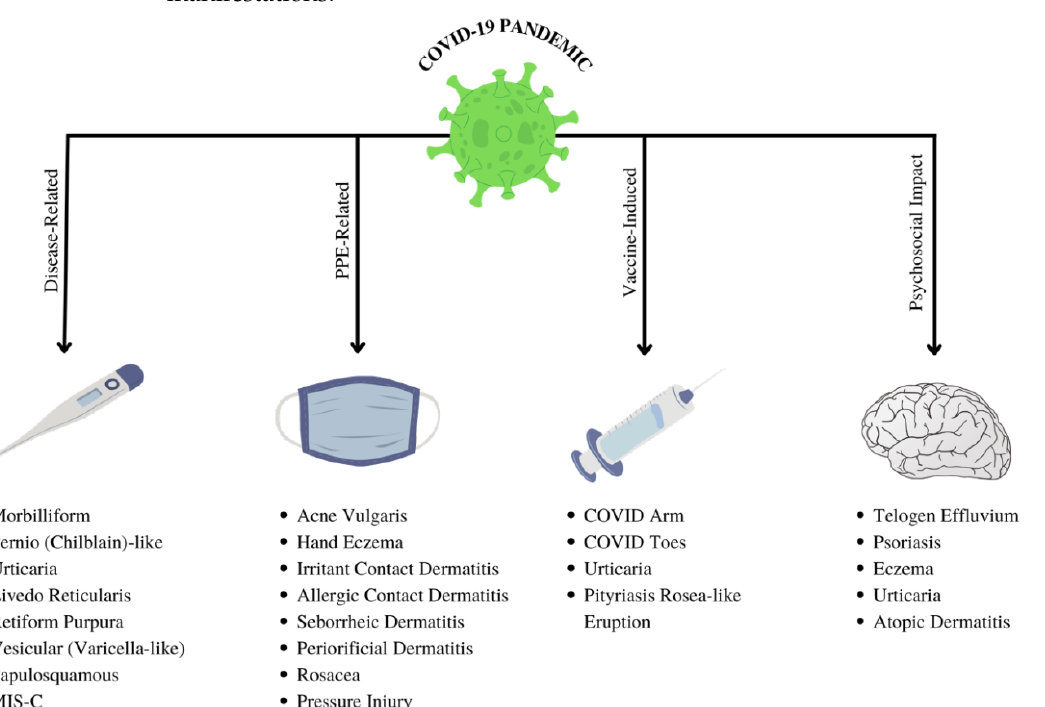
Figure 1. Overview of Cutaneous Manifestations Associated with the COVID-19 Pandemic. MIS-C, Multisystem Inflammatory Syndrome in Children; COVID, Coronavirus Disease.